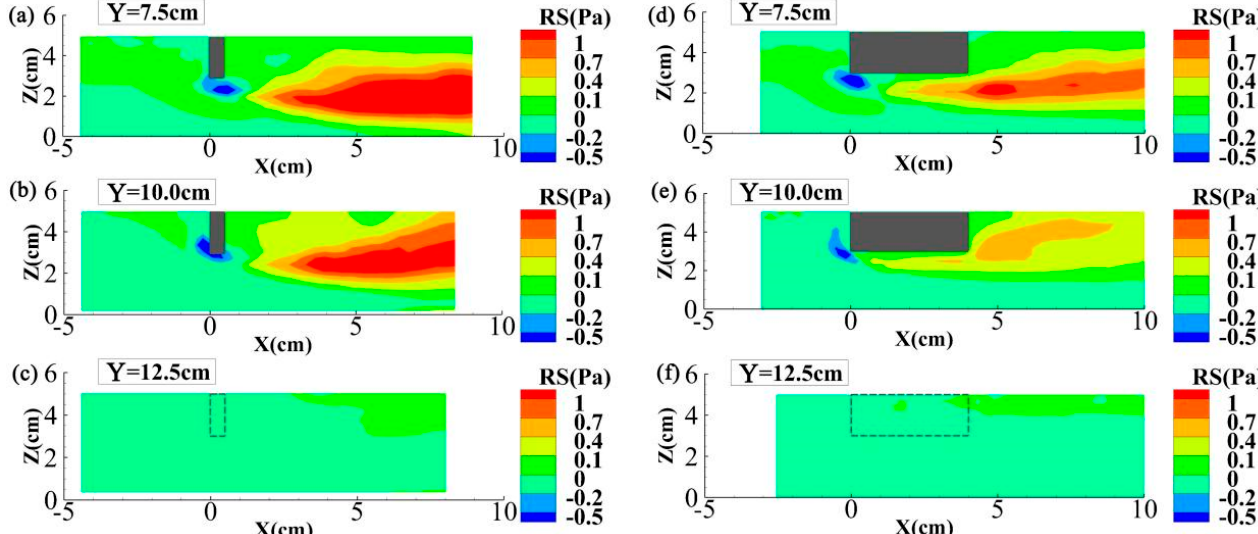
Figure 16. Distributions of the <u’w’> component of Reynolds stress at longitudinal sections ( a ) Y = 7.5 cm, ( b ) Y = 10.0 cm, ( c ) Y = 12.5 cm in Case 7 (on the left) and at longitudinal sections ( d ) Y = 7.5 cm, ( e ) Y = 10.0 cm, ( f ) Y = 12.5 cm in Case 8 (on the right). The grey areas in subfigures ( a ), ( b ), ( d ) and ( e ) demonstrate the floating dike, and the dotted lines in subfigures ( c ) and ( f ) indicate the location of floating dike in the coordinate system.